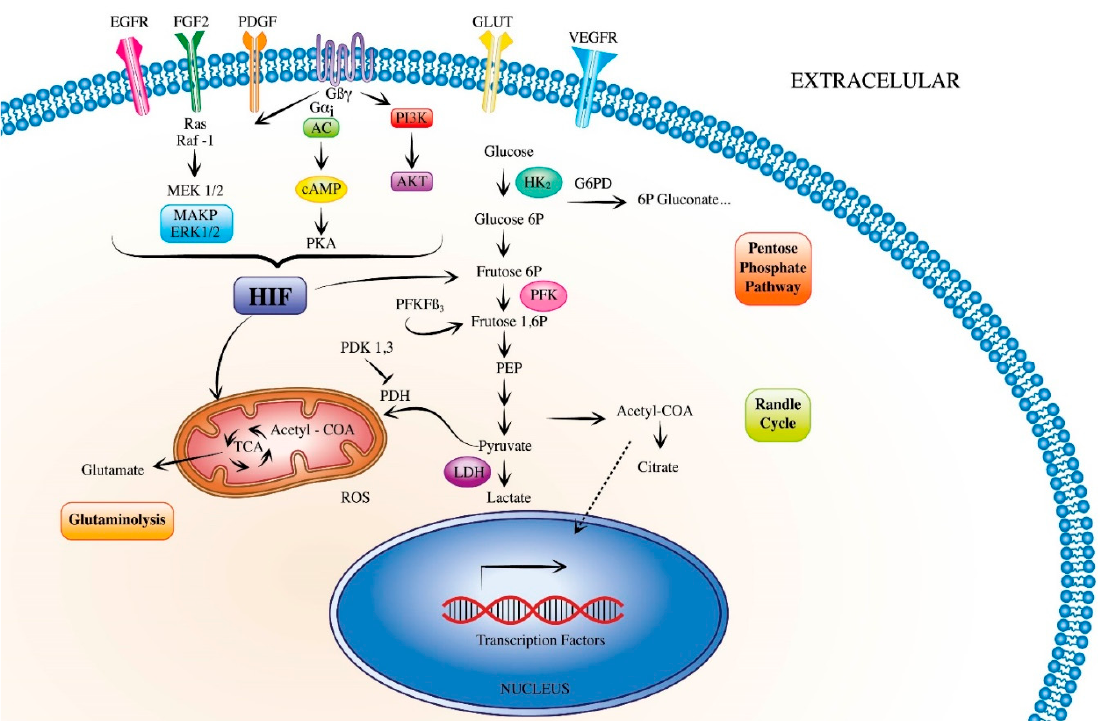
Figure 1. Metabolic signaling pathways promoting pulmonary hypertension. During the develop- ment of pulmonary hypertension, vascular cells release growth factors, which activate the hypoxia- inducible factors (HIF). HIF triggers signaling pathways that have a direct proliferative effect in both endothelial and smooth muscle cells. HIF can also modulate metabolic pathways such as glycolysis, pentose phosphate pathway, randle cycle, glutaminolysis and tricarboxylic acid cycle, which activate several downstream pathways. (EGFR, epidermal growth factor receptor; FGF2, fibroblast growth factor 2; PDGF, platelet-derived growth factor; GLUT, glucose transporter; HIF, hypoxia-inducible factors; ROS, reactive oxygen